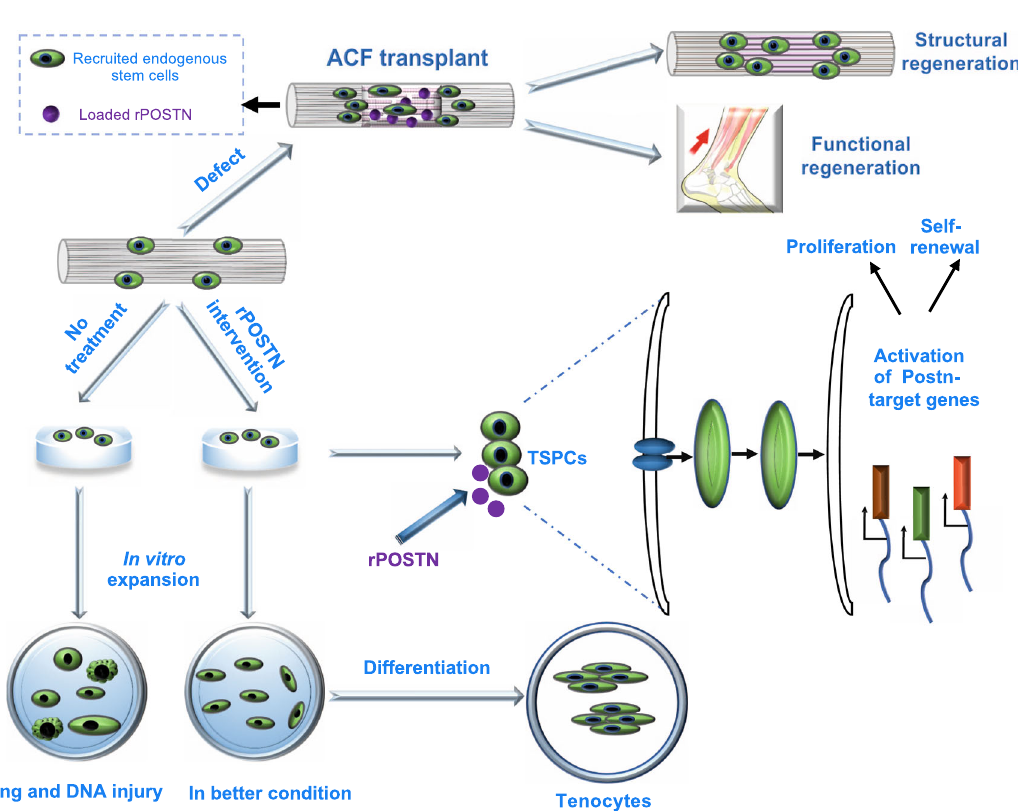
Fig. 8 The potential role of Postn in regulating TSPC functions and tendon regeneration. Schematic illustration shows that rPOSTN modulates TSPC multiple cellular processes, including proliferation, stemness, anti-senescence and tenogenic differentiation in vitro, and boosts structural and functional tendon regeneration by a combination of biomimetic parallel-aligned collagen scaffolds in